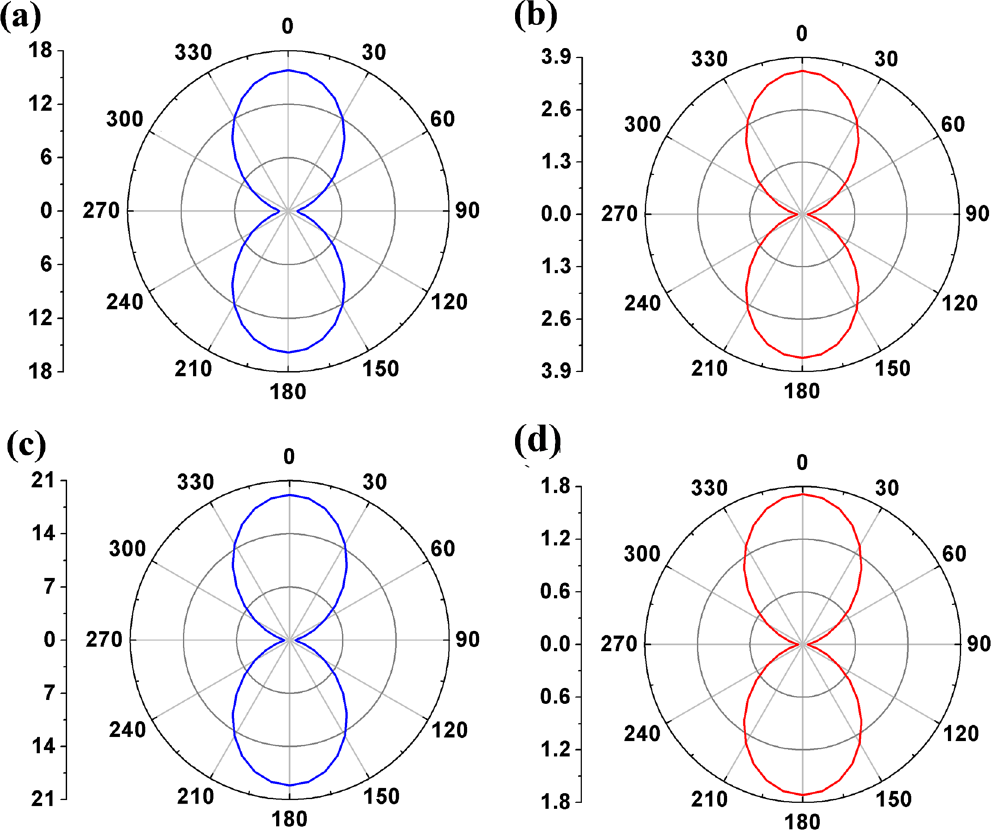
Figure 6. Calculated angle-resolved anisotropic hole mobilities ( a ) and electron mobilities of rubrene ( b ); and calculated angle-resolved anisotropic hole mobilities ( c ) and electron mobilities of fm-rubrene ( d ); here, 0° corresponds crystallographic axis b, and 90° corresponds crystallographic axis